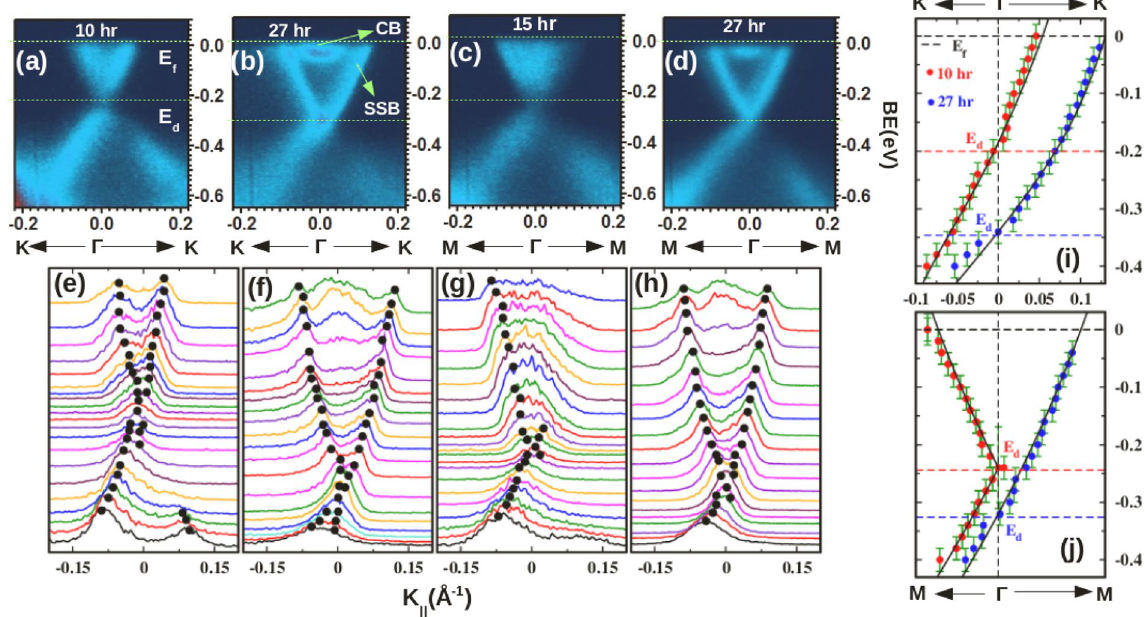
Figure 5. ( a and b ) depict the ARPES intensity plots taken at 31 eV photon energy along the Γ -K direction taken ~10 and 27 hrs. after the sample cleaving. ( c and d ) Show the same images along Γ -M direction collected at different time intervals from the cleaving. ( e – h ) Show MDC spectra extracted from the images ( a – d ). The dispersion relation between E and k estimated from the MDC plots are fitted to the calculated values obtained from the model Hamiltonian 28 along the Γ -K ( i ) and the Γ -M ( j ) directions.